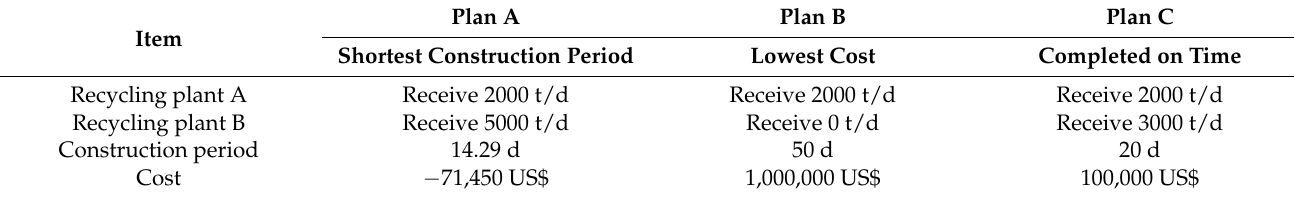
Table 1. Recycling plans for the excavated soil at the depth of 5–10